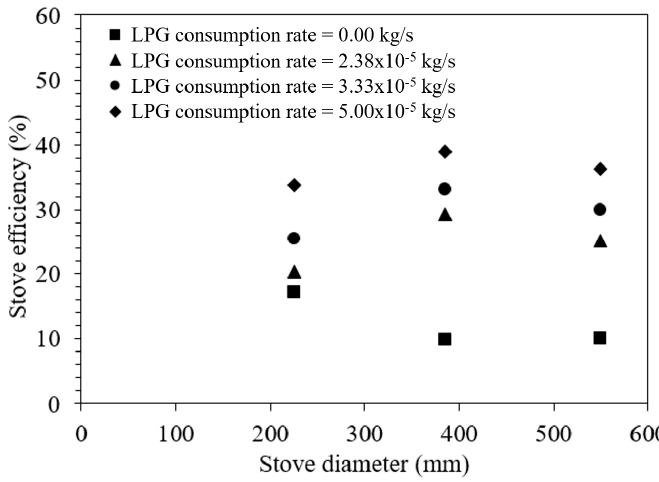
Figure 7. Relationship between stove efficiency and stove diameter.